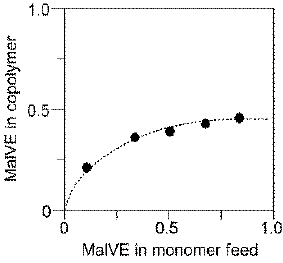
Figure 6. Copolymer composition curve for the copolymerization of MalVE (M 1 ) and EtMI (M 2 ). The dotted line in plot was fitted by the Kelen – Tüdõs method, assuming that the values of r 11 and r 21 are 0.